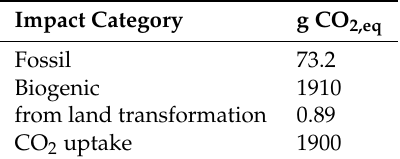
Table 5. Summary of the carbon footprint.